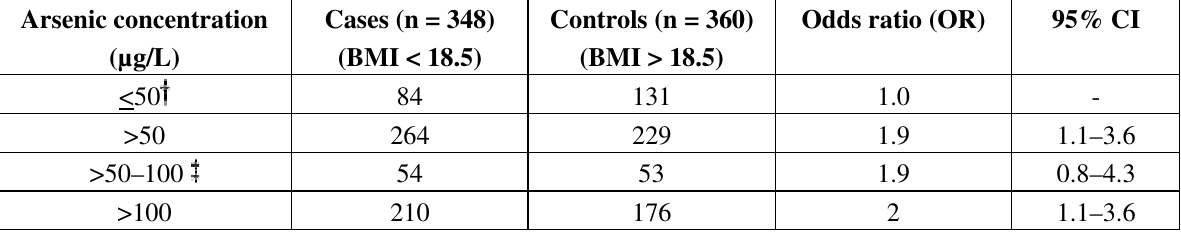
Table 2. Association between arsenic concentrations with nutritional status of the women of reproductive age*.